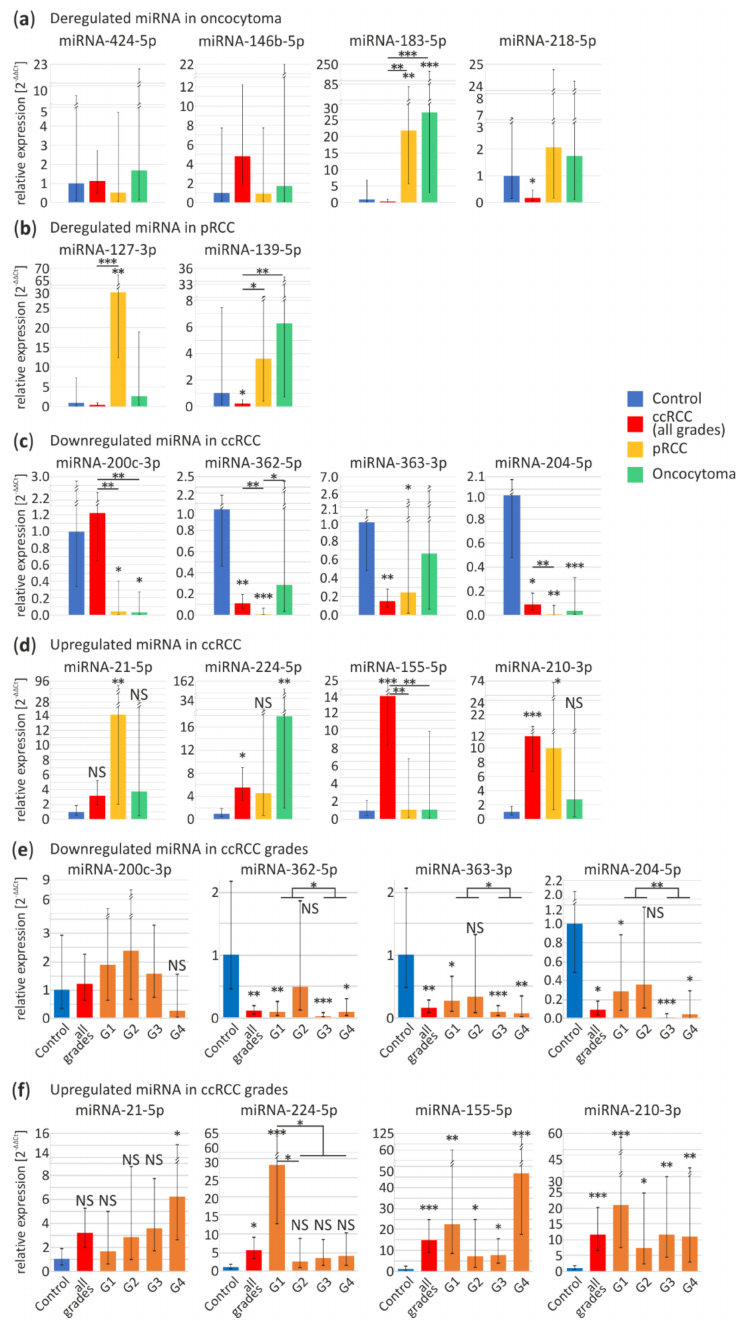
Figure 2. Validation of commonly deregulated miRNA in the independent sample set of ccRCC, pRCC and oncocytoma tumors by quantitative PCR (qPCR). ( a , b ) Specifically deregulated miRNA in oncocytoma ( a ) and pRCC ( b ) tumors based on a meta-analysis compared to other subtypes. Analyzed specimens included: control ( n = 9), ccRCC ( n = 11), pRCC ( n = 10), oncocytoma ( n = 8) samples; ( c – f ) Validation of expression disruptions of commonly deregulated miRNA in RCC tumors. Downregulated ( c ) and upregulated ( d ) miRNA in ccRCC tumors based on a meta-analysis compared to pRCC and oncocytoma. Analyzed specimens included: control ( n = 15), ccRCC ( n = 39), pRCC ( n = 11), oncocytoma ( n = 8) samples; ( e , f ) miRNA expression in ccRCC tumors grouped according to Fuhrman grade: downregulated ( e ) and upregulated ( f ) miRNA in ccRCC tumors based on a meta-analysis. Analyzed specimens included: control, n = 15; ccRCC ( n = 39), ccRCC G1 ( n = 9), ccRCC G2 ( n = 11), ccRCC G3 ( n = 10), ccRCC G4 ( n = 9) samples. Blue bars, control tissue; red bars, ccRCC tumors; orange bars, ccRCC Fuhrman grades; yellow bars, pRCC; green bars, oncocytoma; ccRCC, clear renal cell carcinoma; pRCC, papillary renal cell carcinoma; G1-G4, ccRCC Fuhrman grades 1–4. NS, non-significant; * p < 0.05; ** p < 0.01 and *** p <